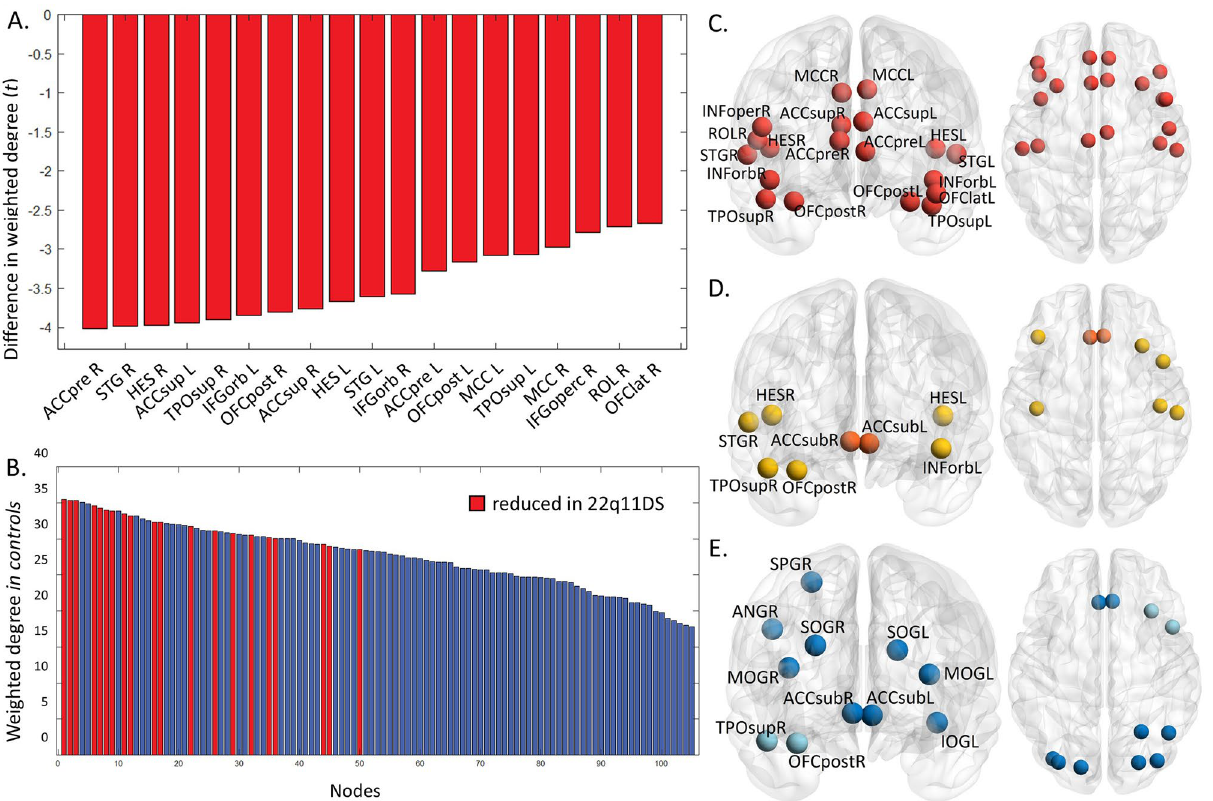
Figure 2. Weighted degree is decreased in highly connected hubs of 22q11 deletion syndrome patients. ( A ) T-values of weighted degree comparison between patients and control subjects, nineteen nodes are significantly reduced after FDR correction. ( B ) Ranking of nodes by average weighted degree in control subjects, nodes with significant lower weighted degree in patients are highlighted in blue. Most affected nodes are depicted on the left side, indicating connector hubs are mostly affected in 22q11DS. ( C ) Physical location of nodal reductions of weighted degree of the 22q11 deletion syndrome network ( p < 0.05 FDR corrected). ( D ) Abnormal local efficiency in nodes of the 22q11 deletion syndrome network ( p < 0.05 FDR corrected), reductions are visualized in yellow and increases in orange. ( E ) Nodes in 22q11 deletion syndrome patients presented with abnormal nodal global efficiency, reductions are visualized in light blue and increases in dark blue. WD: weighted degree; eLoc: local efficiency; L: left;: right; TPOsup: temporal pole: superior temporal gyrus; STG: superior temporal gyrus; HES: Heschl’s gyrus; OFCPOST: posterior orbital gyrus; ACCsup: anterior cingulate cortex (supracallosal); ACCpre: anterior cingulate cortex (pregenual); IFGorb: inferior frontal gyrus (opercular part); MCC: middle cingulate; IFGoperc: inferior frontal gyrus, opercular part); ROL: rolandic operculum; SMA: supplementary motor area.